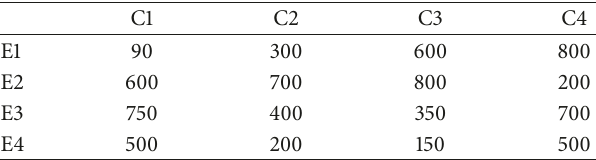
Table 1: Link remaining bandwidth ( M